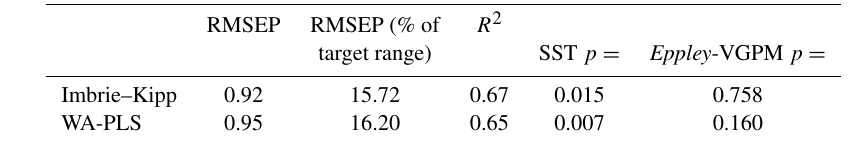
WA-PLS = weighted-averaging partial-least-squares